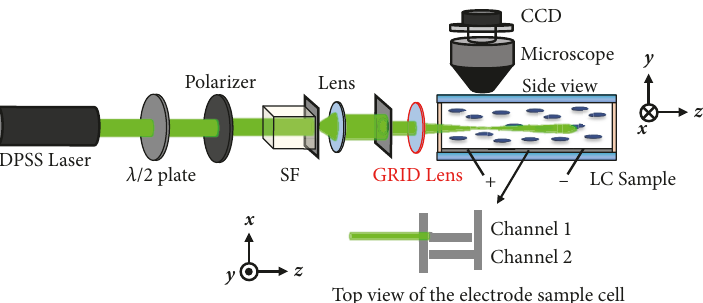
Figure 1: Experimental setup of voltage-controllable guided propagation in a nematic liquid crystals coupler.